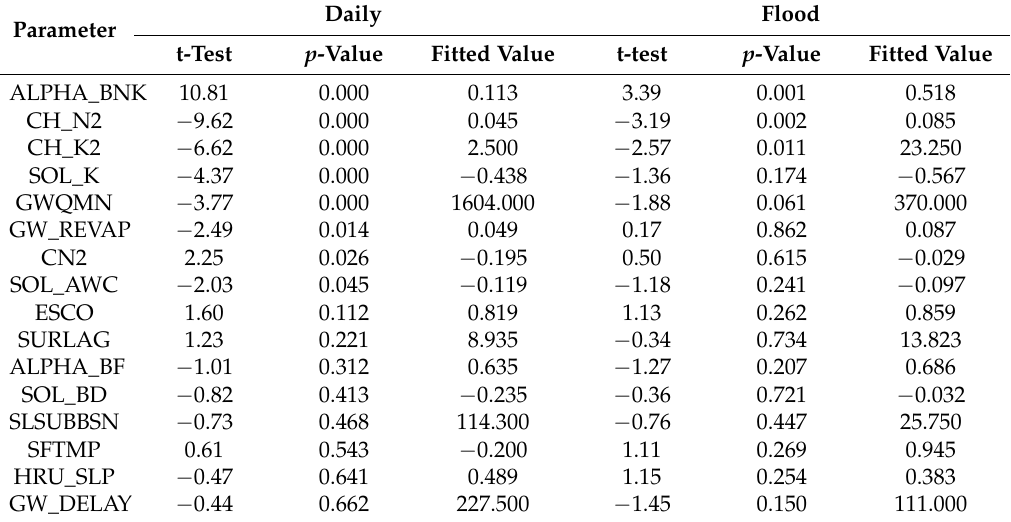
Table 3. Parameter sensitivities for SWAT model in daily and flood